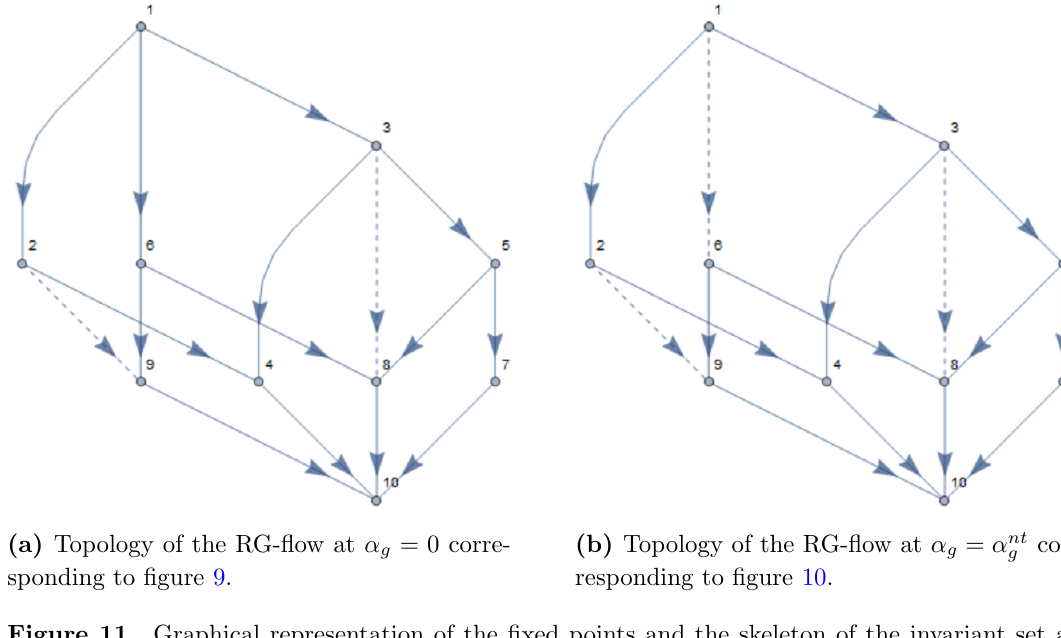
(b) Topology of the RG-(cid:13)ow at (cid:11) g = 0 corre- responding to (cid:12)gure 10. g